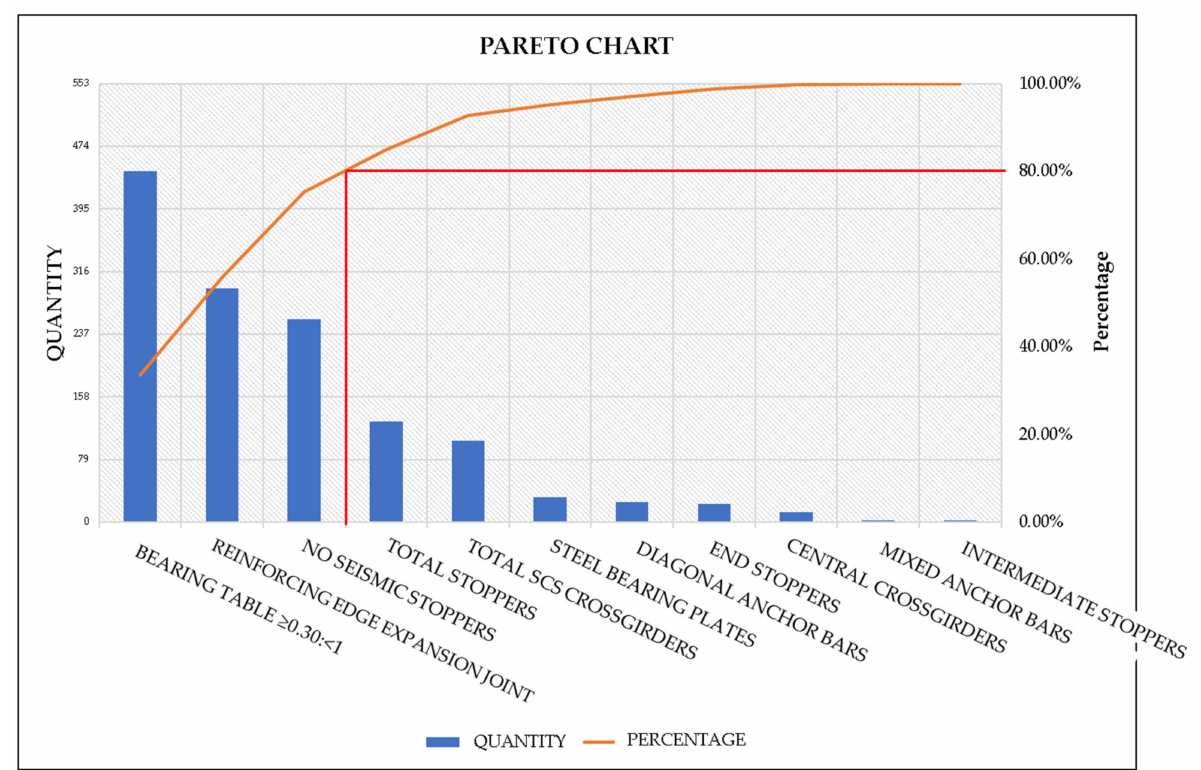
Figure 11. Global Pareto chart that shows the variability of the seismic protection components of bridges throughout